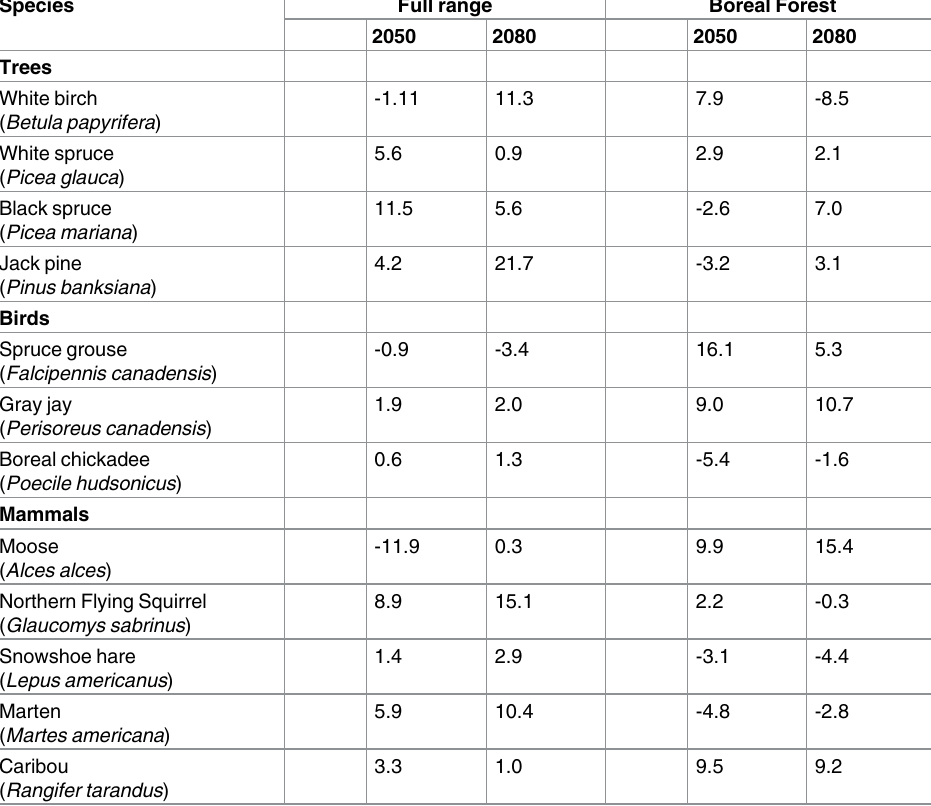
Table 3. Percent change in nearestneighbor distance for boreal forest species between current and future climate projections (2050, 2080), within the full range of each species and the boreal forest.